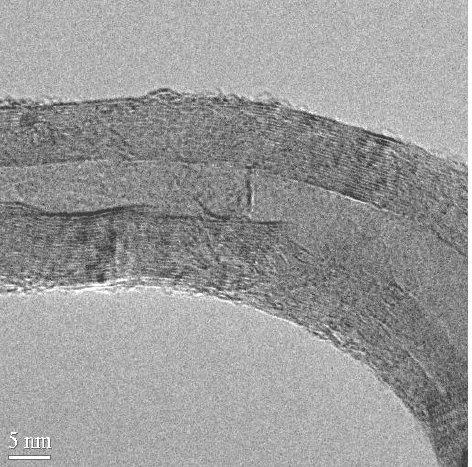
Figure 11. Defects allowing curvature at a strong bend of a spiral. On the upper part, the stretching of the planes leads to a regular curvature. In the inner part of the spiral both plane buckling, and interrupted layers close to the core can be seen. Reproduced from [25] with